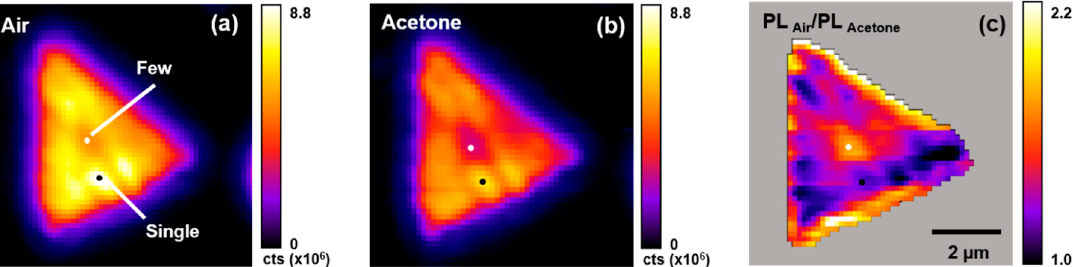
Figure 4. Typical total PL emission intensity maps (1.8–2.1 eV) for a single WS 2 flake on TSG. ( a ) Air atmosphere. ( b ) Acetone atmosphere. ( c ) PL Air / PL Acetone intensity response map. The black and white dots indicate single- and few-layer WS 2 regions determined from Figure 3c.